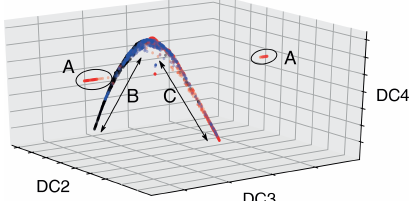
Figure 7. Diffusion map projection of the modern and ancient data. Black: modern; blue: Eocene (Inglis et al., 2015); red: Cretaceous (O’Brien et al., 2017). Separate clusters marked “A” are the out- lying Cretaceous points with high GDGT-3 values. Branch “B” is dominated by modern data points; branch “C” by Cretaceous